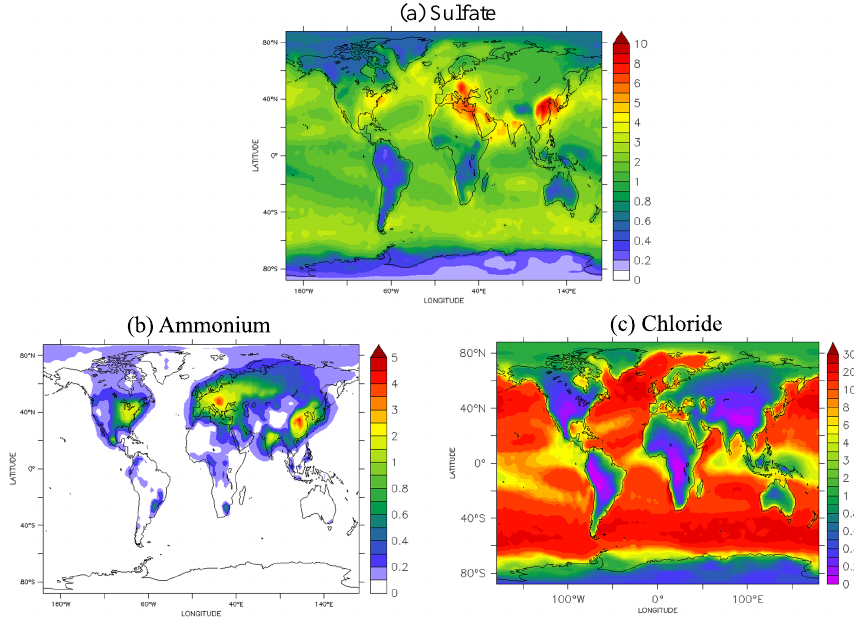
Figure 4. Predicted average near-surface concentrations (in µgm − 3 ) of (a) sulfate, (b) ammonium, and (c) chloride during the years 2005–